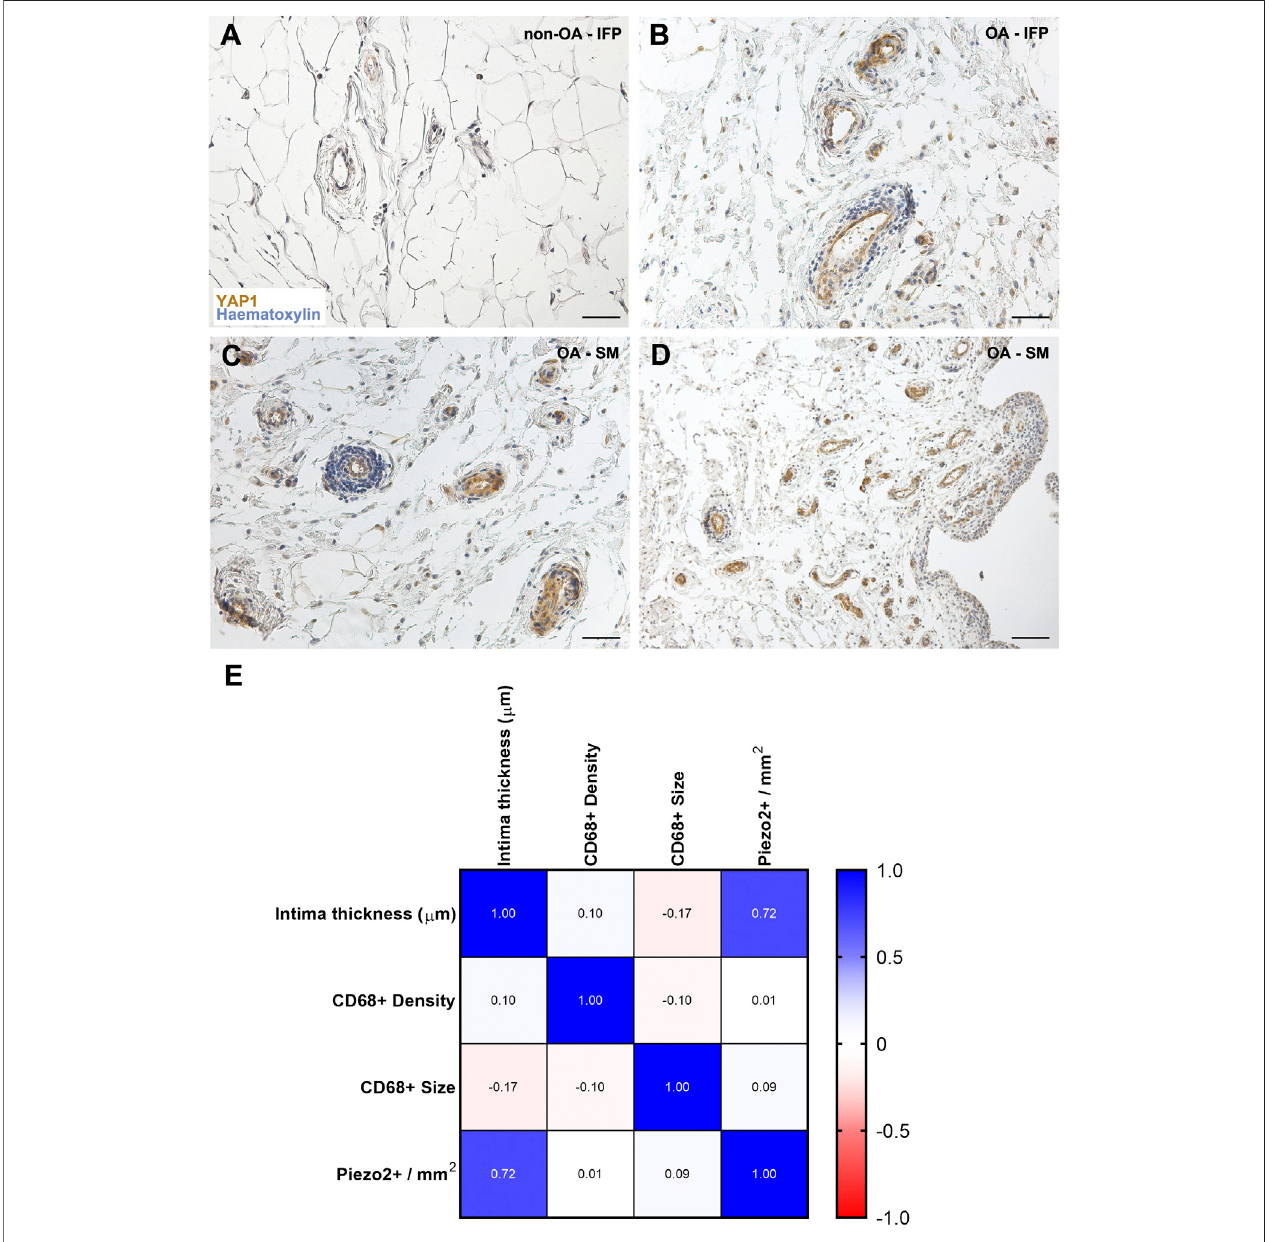
FIGURE 5 | (A – D) YAP1 pattern distribution within the non-OA (A) and diseased (B – D) AFUs by immunohistochemistry. (E) Correlation matrix reveals a positive correlation only between intima thickness and Piezo2+ vessel density, while no relationship was found between the other studied variables. Scale bars: 50 µm (A – C) ; 100 µm (D)